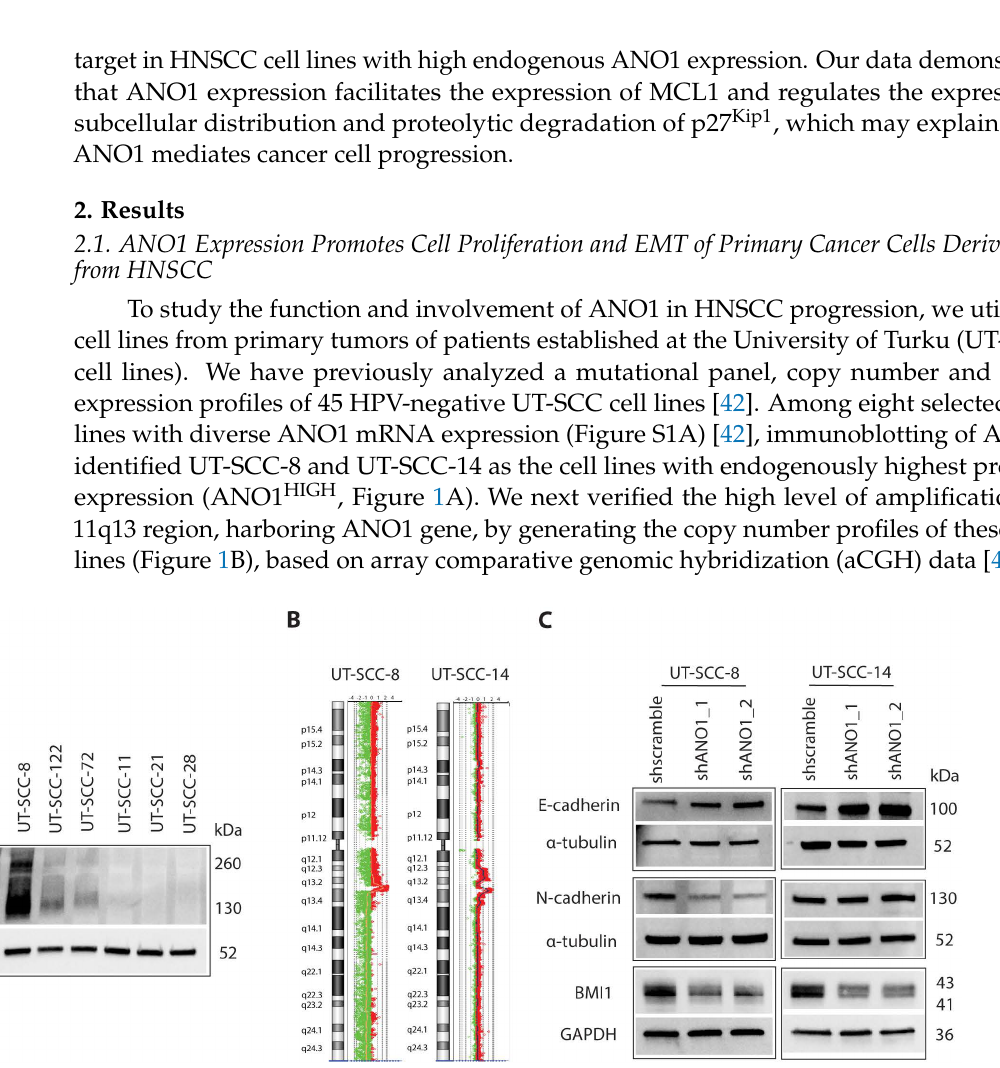
Figure 1. Comparison of ANO1 amplification and expression in a panel of University of Turku-Squamous Cell Carcinoma (UT-SCC) cell lines, and the effect of ANO1 expression on epithelial-to-mesenchymal transition (EMT). ( A ) Western Blot illustrating the expression of ANO1 in a panel of UT-SCC cell lines with diverse endogenous ANO1 expression levels. ( B ) Array comparative genomic hybridization (aCGH) profiles of chromosome 11 for UT-SCC-8 and UT-SCC-14 cell lines illustrating the high copy number amplification of 11q13. ( C ) Western blot analysis of EMT markers E-cadherin and N- cadherin, and stem cell marker BMI1 in shANO1 and shScramble cell lines. GAPDH and α -tubulin are the loading